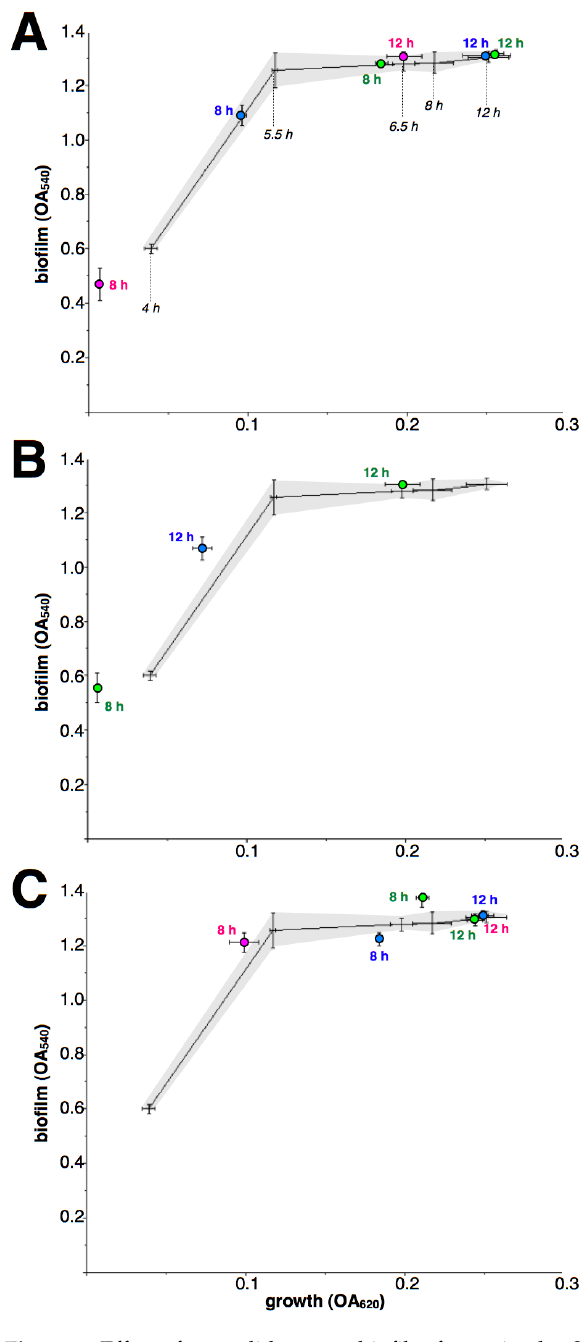
Figure 5. Effect of macrolides upon biofilm formation by S. aureus strain e1 (efflux). Lines (means of four independent experiments) and dashed areas (defined by standard deviations of each point) show the relationship growth/biofilm formation (as OA at 620 and 540 nm, respectively) in the absence of antibiotics at 4, 5.5, 6.5, 8 and 12 h (indicated with black italics only in the top figure). The effect of ERY ( A ), CLA ( B ) and AZI ( C ) at 8 and 12 h is shown as circles (means with standard deviations of four independent experiments), green for 0.5 µ g/mL, blue for 1 µ g/mL, and magenta for 2 µ g/mL; close to each symbol, numbers indicate incubation time. Missing data was caused by non-detectable growth (CLA 2/8 and CLA